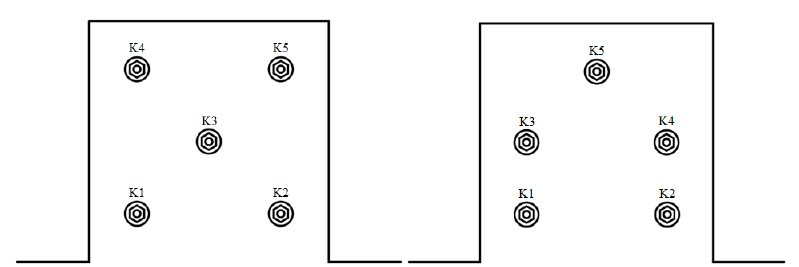
Figure 10. Diagram of anchor arrangement (left: Klein II transverse plane; right: Vernier longitudi- nal plane).